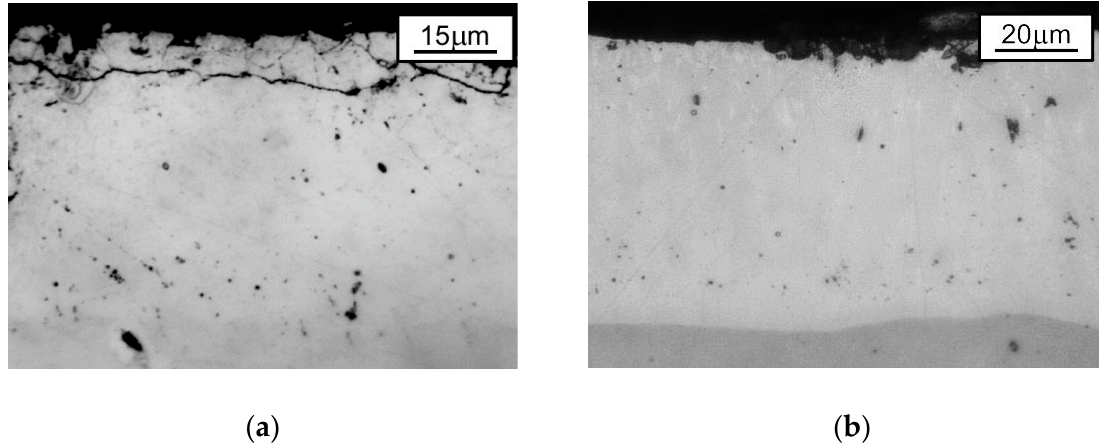
Figure 5. The microstructure (optical microscope images) observed at the cross section of the tested zinc coatings deposited on disc-shaped samples: ( a ) TD coating; ( b ) HDHT coating.